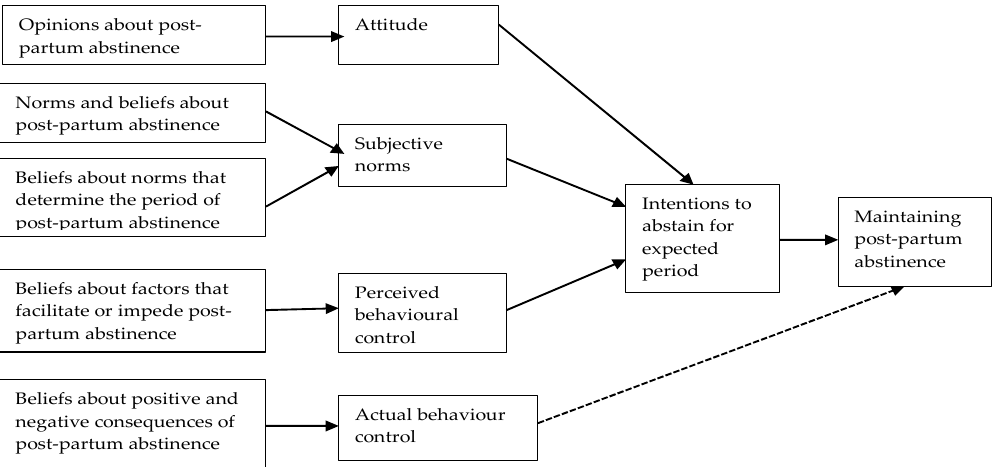
Figure 1. Adapted TPB model on post-partum sexual abstinence.